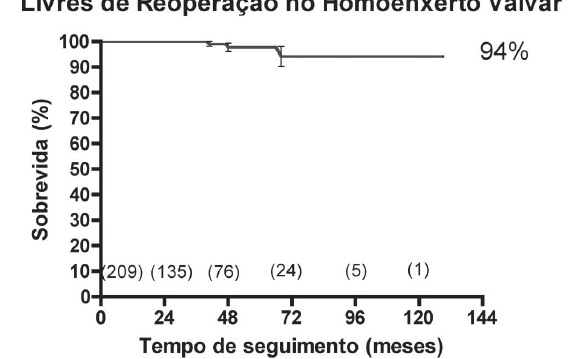
Fig. 5 - Probabilidade de reoperação no homoenxerto,